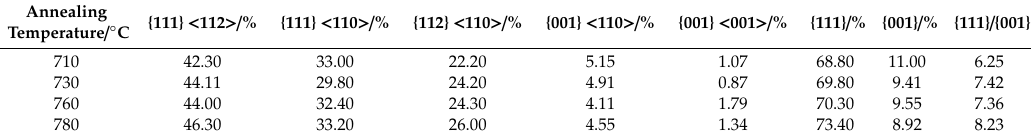
Table 2. Volume fractions of typical textures at di ff erent annealing